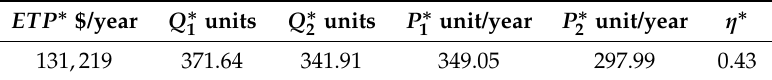
Table 3. The optimal values of Example